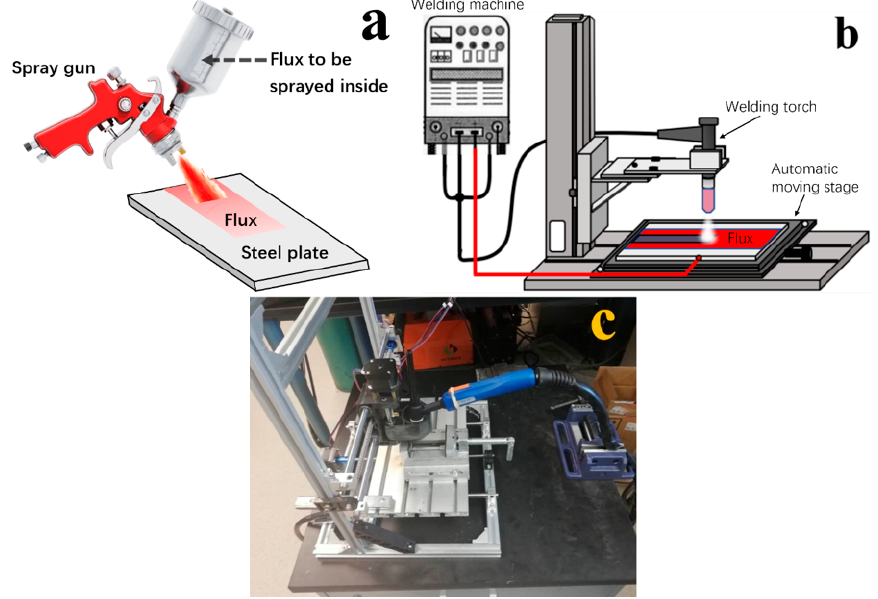
Figure 2. ( a ) Spray coating of active flux to thick steel plate; ( b ) Schematic figure of A-TIG weld- ing; ( c ) Photo of real experimental set up.